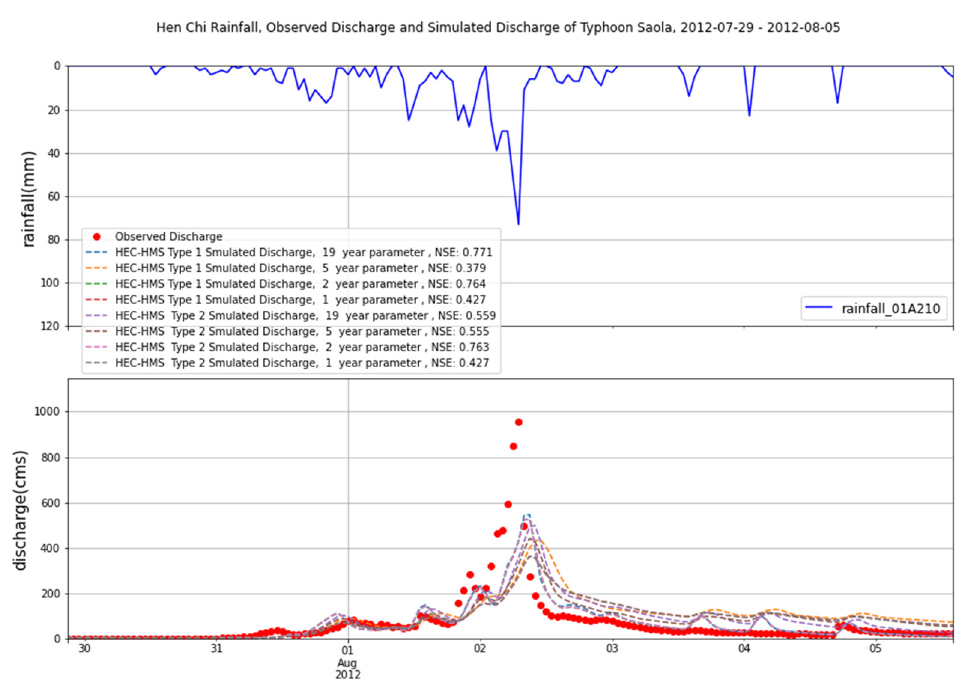
Figure 4. The measured rainfall time series (upper panel) and their corresponding rainfall-runoff simulations (lower panel) of the HEC-HMS model using different parameter optimization approaches for Typhoon Saola.